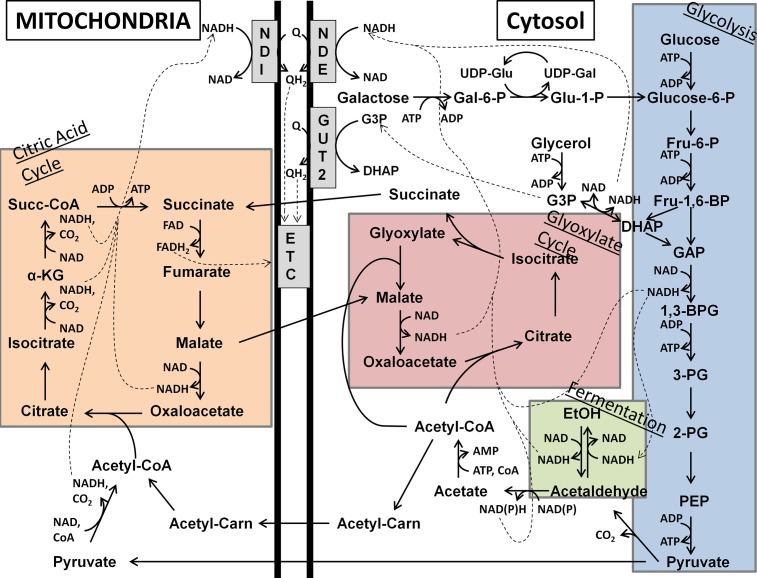
Known routes for production of NADH and subsequent contribution to mitochondrial electron transport chain from catabolism of various carbon sources.Included are glycolysis (blue), the glyoxylate cycle (rose), fermentation (green), and the citric acid cycle (orange), as well as the connecting steps between the pathways. Also shown are the routes for entry of galactose and glycerol catabolic products into the core glycolysis pathway. Abbreviations not described in the text are as follows: Fru-6-P, fructose-6-phosphate; Fru-1,6-BP, fructose-1,6-bisphophate; GAP, glyceraldehyde-3-phosphate; 1,3-BPG, 1,3-bisphosphoglycerate; 3-PG, 3-phosphoglycerate; 2-PG, 2-phosphoglycerate; PEP, phosphoenolpyruvate; Gal-6-P, galactose-6-phosphate; Glu-1-P, glucose-1-phosphate; UDP-Glu, UDP-glucose; UDP-Gal, UDP-galactose; Acetyl-Carn, acetylcarnitine; α-KG, alpha-ketoglutarate; Succ-CoA, succinyl-CoA; GUT2, mitochondrial G3P dehydrogrenase; ETC, electron transport chain.